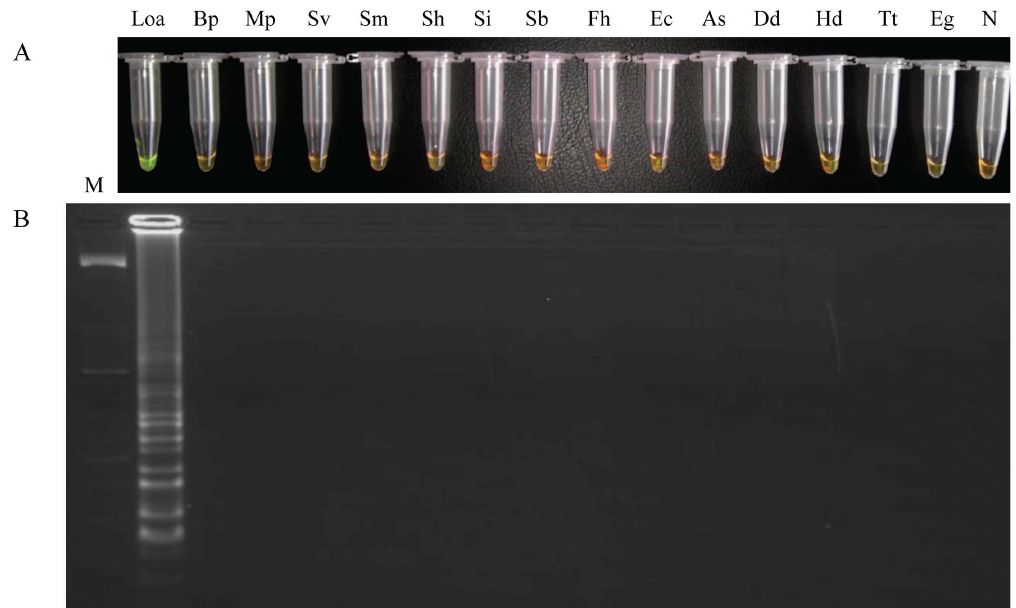
Figure 3. Specificity assessment of LAMP assay. (A) Visual examination of LAMP products by adding SYBR Green I. (B) Agarose gel electrophoresis of amplified products. Lanes Loa, Bp, Mp, Sv, Sm, Sh, Si, Sb, Fh, Ec, As, Dd, Hd, Tt, Eg: DNA from Loa loa , Brugia pahangi, Mansonella perstans, Strongyloides venezuelensis, Schistosoma mansoni, Schistosoma haematobium, Schistosoma intercalatum, Schistosoma bovis , Fasciola hepatica , Echinostoma caproni, Anisakis simplex , Dicrocoelium dendriticum, Hymenolepis diminuta , Taenia taeniformis and Echinococcus granulosus , respectively. Lane M: 50 bp DNA ladder (Molecular weight marker XIII, Roche); lane N: negative control (no DNA template).